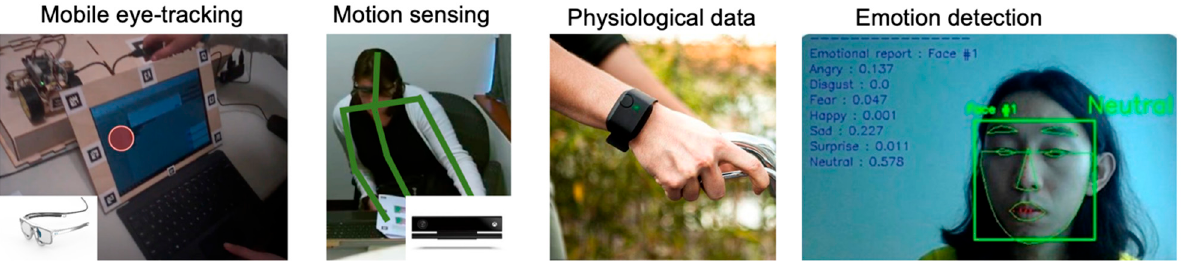
Figure 1. Use of sensors in a typical multimodal study. Left: mobile eye-tracker. Middle: Motion sensors and Electrodermal wristbands (Empatica E4). Right: emotion detection from facial expres- sions. Mobile eye-trackers are expensive wearable sensors and data processing software tend to be proprietary. The Kinect sensor is more affordable but does not come with an easy-to-use data collection package; recording the data requires some programming knowledge. The Empatica E4 is also relatively expensive and data extraction requires proprietary software.